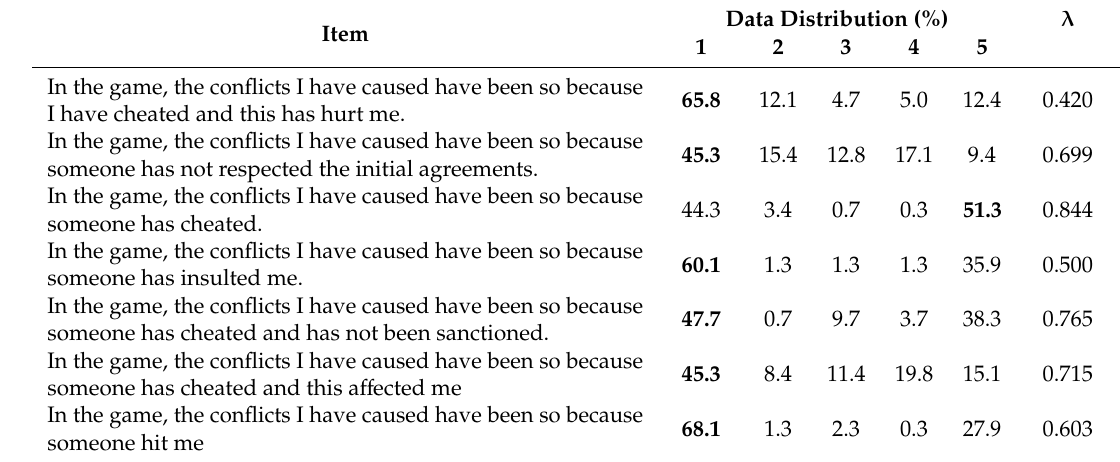
Data Distribution (%)